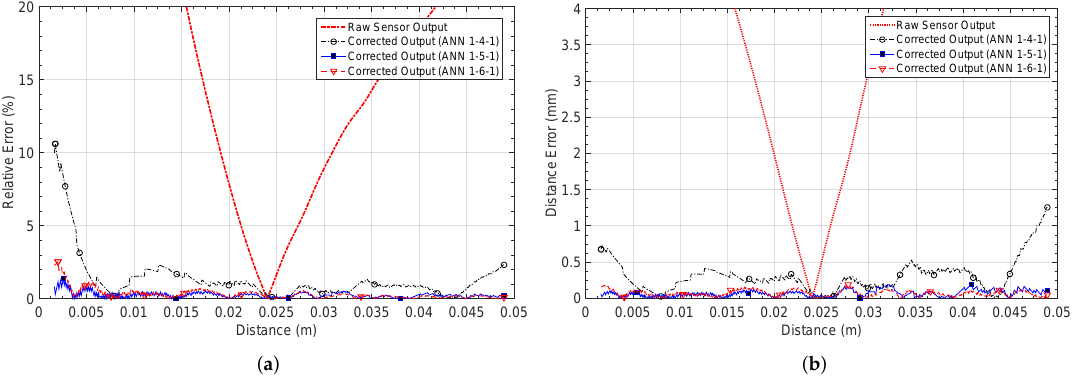
Figure 13. Calculated errors by considering the non-linear characteristic 2 (NL2): ( a ) relative error e r and ( b ) distance estimation error e D .